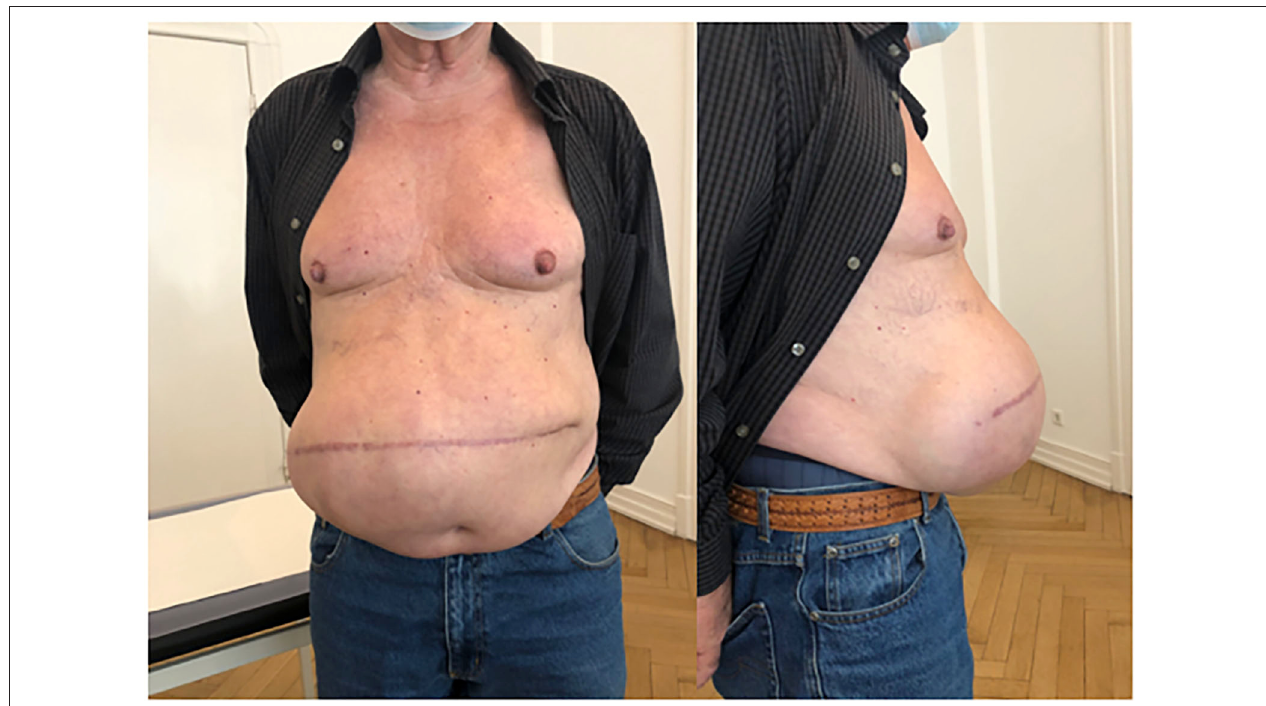
FIGURE 8 | Patient 2 preoperative (transverse scar hernia), private archive Prof. Dr. H. Niebuhr